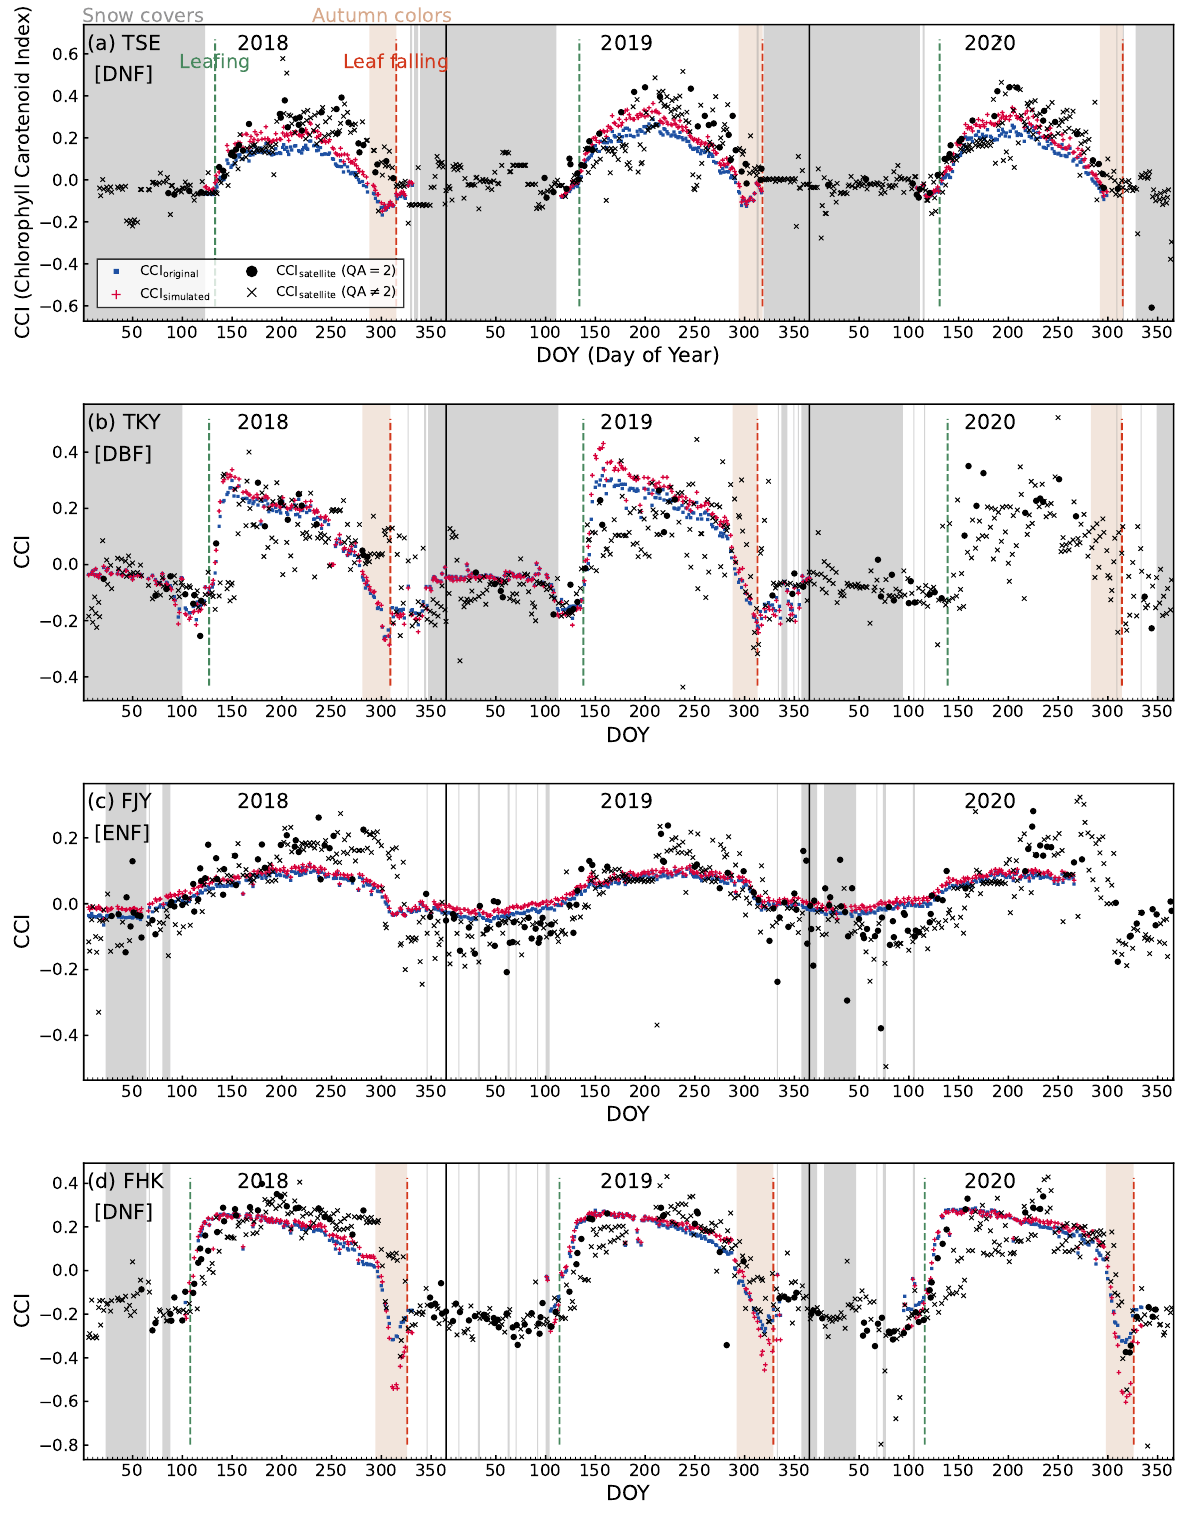
Figure 9. Time series of CCI original , CCI simulated , and CCI satellite from 2018 to 2020 at the four study sites. The blue square is CCI original , the red plus is CCI simulated , the black circle is CCI satellite not screened with the QA flag, and the black cross is CCI original screened with the QA flag. The gray bands are snow seasons, the orange bands are autumn colors seasons, the green dotted lines are leafing timings, and the red dotted lines are leaf falling